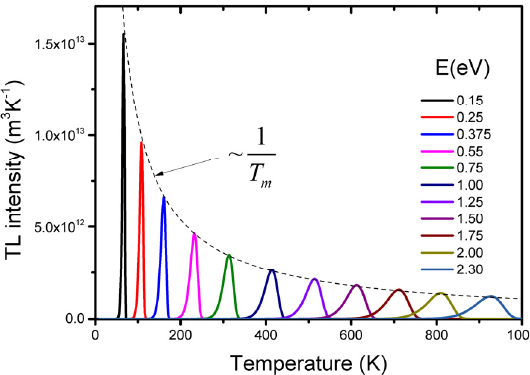
Figure 3. TL glow peaks calculated with the Randall-Wilkins Equation (4) for n 0 = 10 14 m − 3 ; s = 10 11 s − 1 , E = 1 eV and different values of the heating rate β .